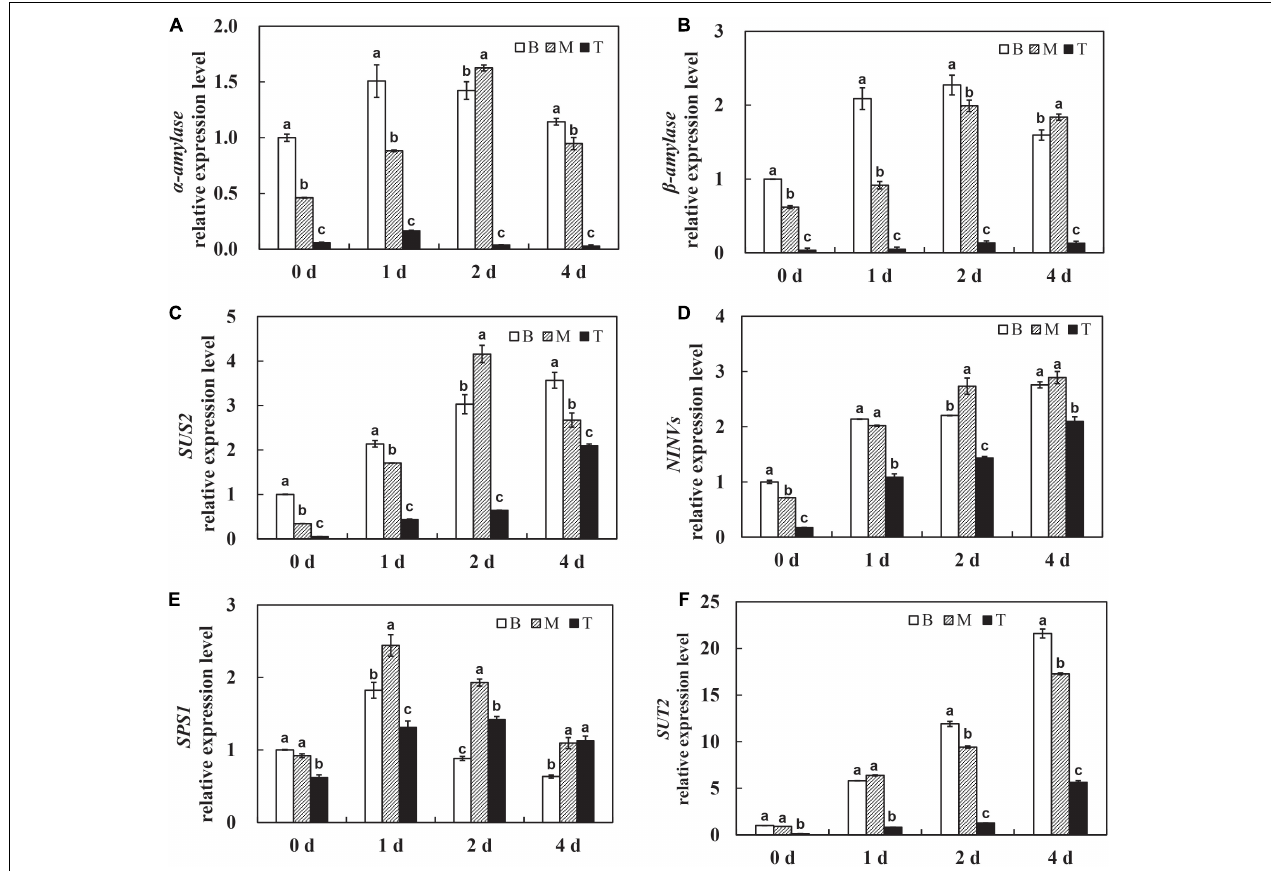
FIGURE 3 | Expression patterns of starch and sucrose metabolism related genes during dodder shoots growth in vitro. (A–F) Transcript levels of α -amylase (A) and β -amylase (B) , SUS2 (C) , NINVs (D) , SPS1 (E) , and SUT2 (F) , respectively. Bars marked with the same letter represent no significant difference between each other protected with Fisher’s least significant difference (LSD) at P <